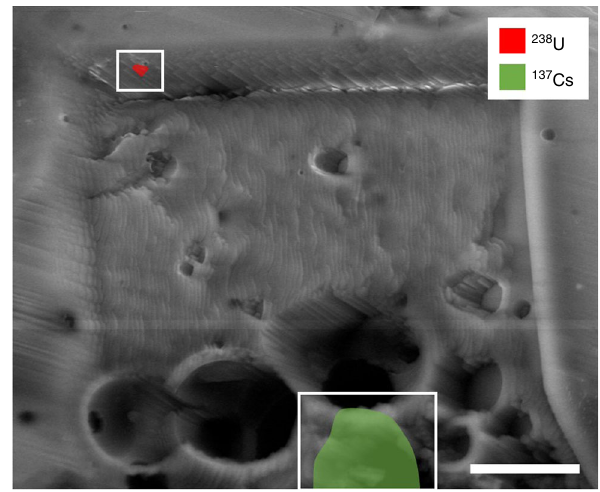
Fig. 3 SIMS depth-pro fi le compositional mapping: compositional mapping results ( 238 U and 137 Cs) overlain onto the trench produced following SIMS depth-pro fi ling into FIB-cut face. Scale bar = 10 μ m